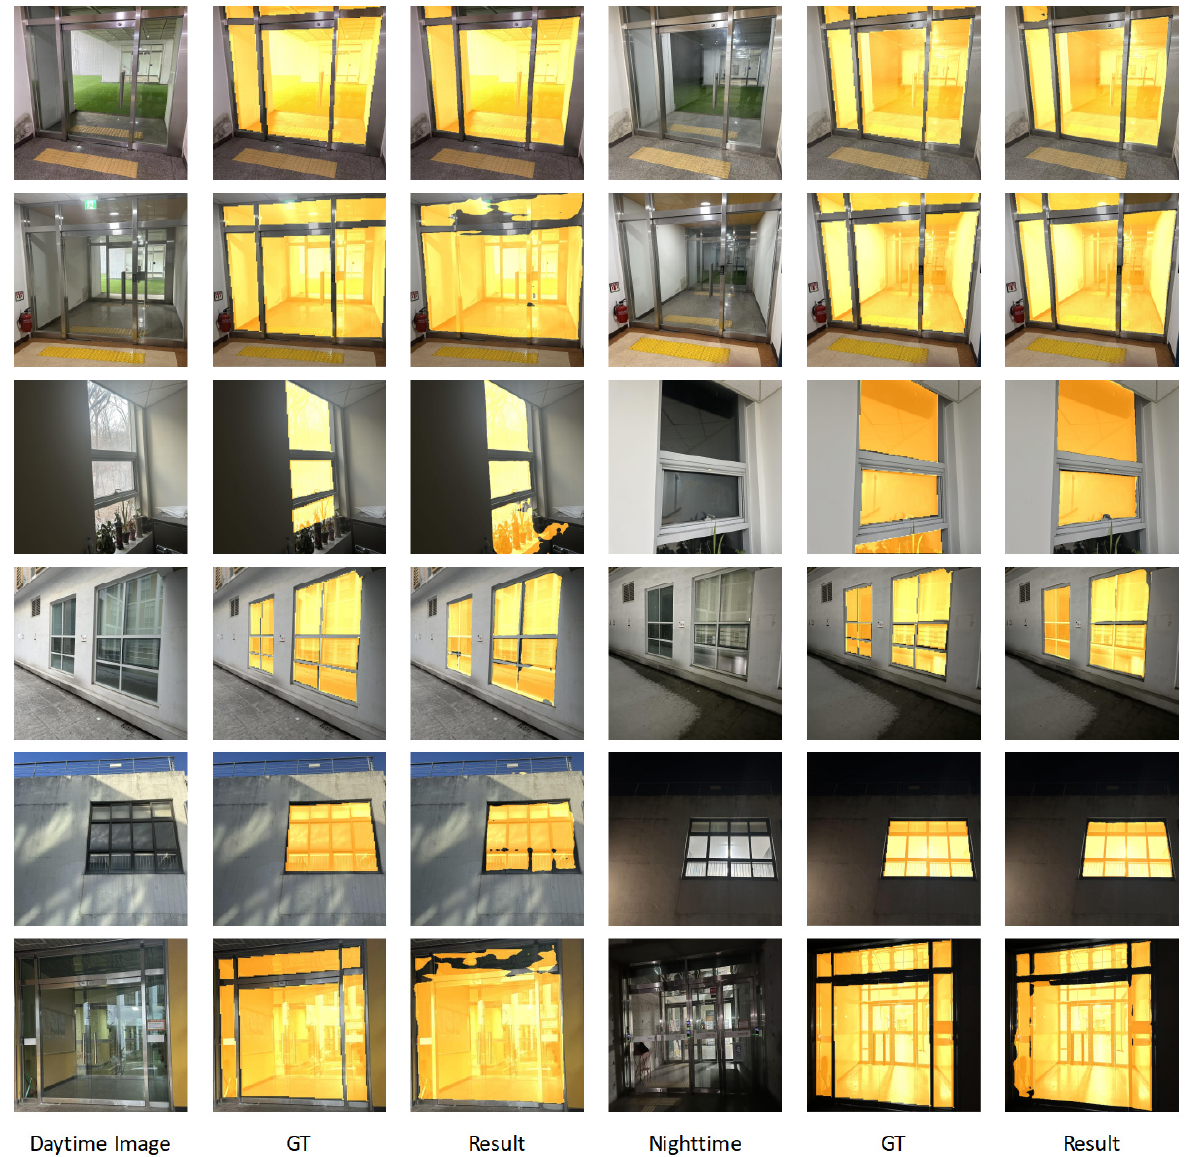
Figure 10. Results under different lighting conditions (day and night).